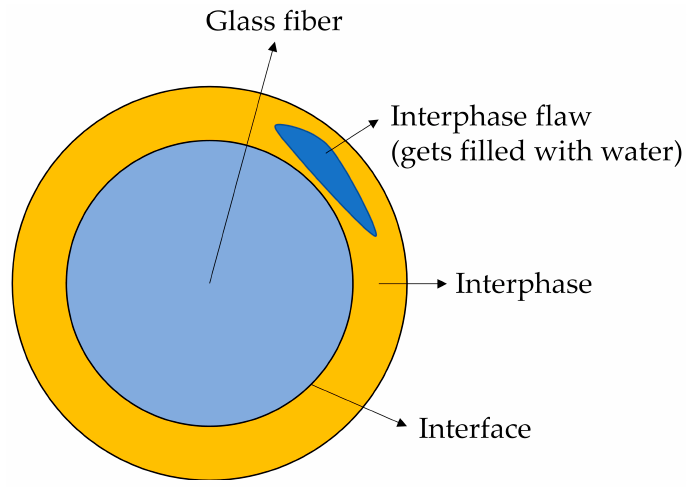
Figure 10. Interphase flaw is formed and is filled with